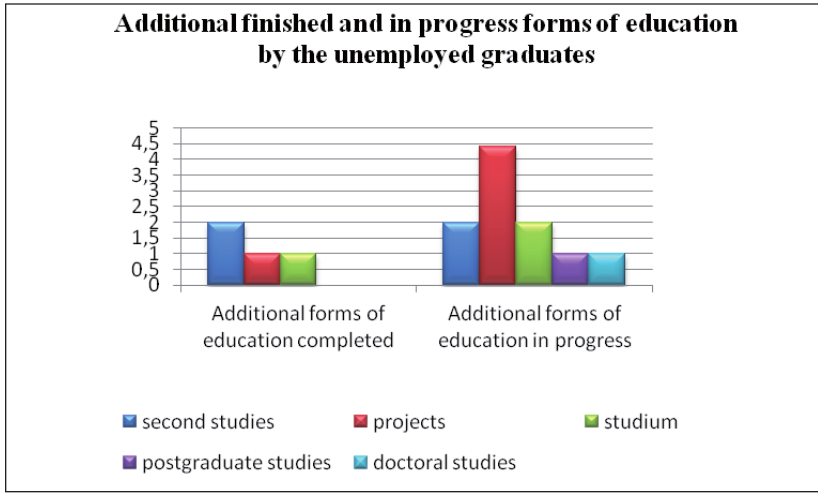
Fig. 8. Additional forms of education- fi nished and currently taken by the